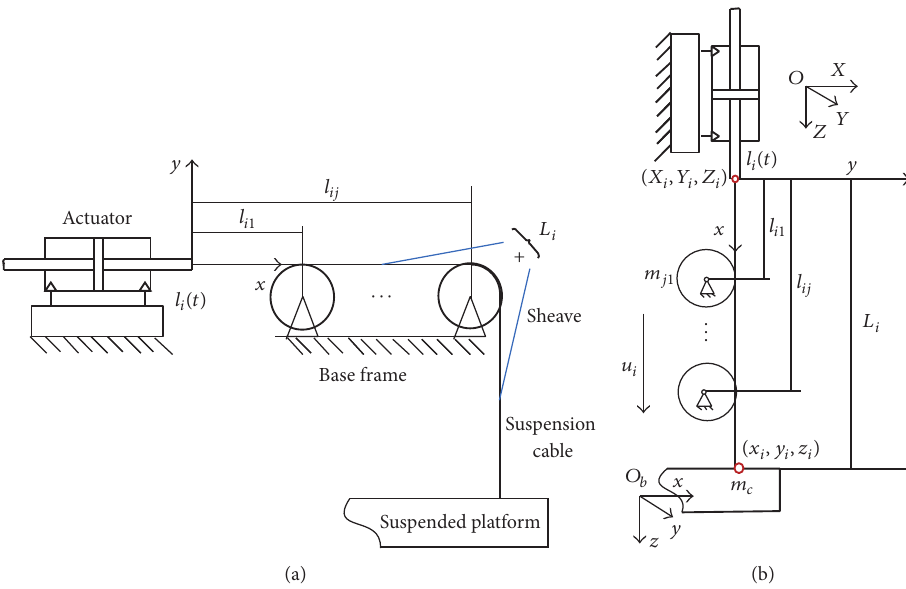
Figure 2: The 𝑖 th suspension system